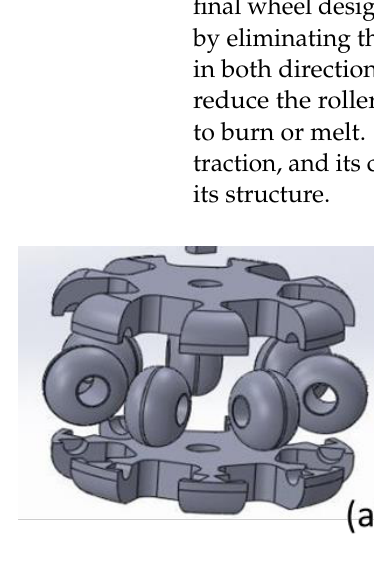
Figure 5. Universal omnidirectional wheel for pipeline robot; ( a ) Cad Model. ( b ) Omnidirectional wheel with thermofit.